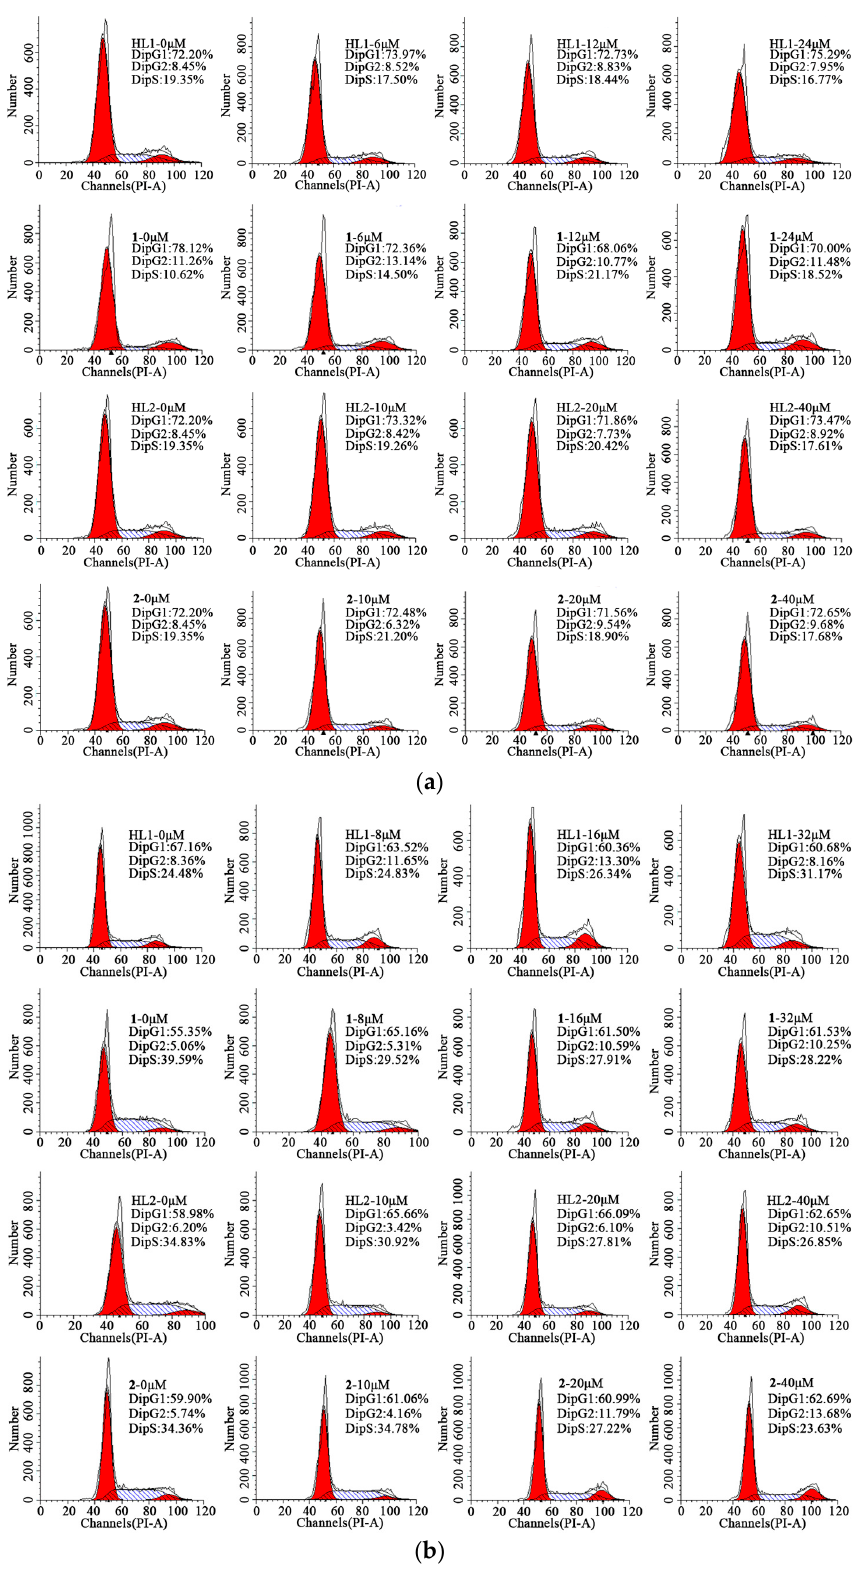
Figure 6. Cell cycle arrest. ( a ) Effects of HL1, HL2, 1 , and 2 on the cell cycle of HepG2 cells after incubation for 48 h; ( b ) Effects of HL1, HL2, 1 , and 2 on the cell cycle of MGC80-3 cells after incubation for 48 h.